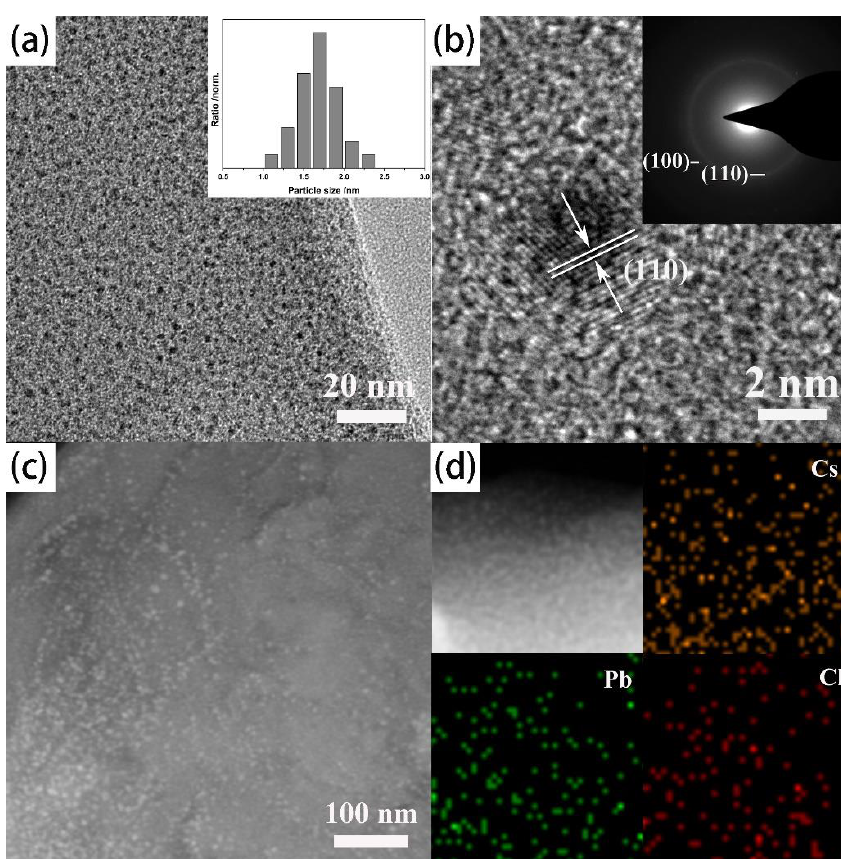
Figure 2. ( a ) The represent TEM image of CsPbCl 3 perovskite quantum dots and narrow size distribution insets of figure. ( b ) The high-resolution transmission electron microscope (HRTEM) and selective area electron diffraction (SAED) images of CsPbCl 3 @Cu-BDC. ( c ) HAADF-STEM image of CsPbCl 3 quantum dots. ( d ) The elemental mapping images showing the elemental distribution of Cs, Pb, and Cl.